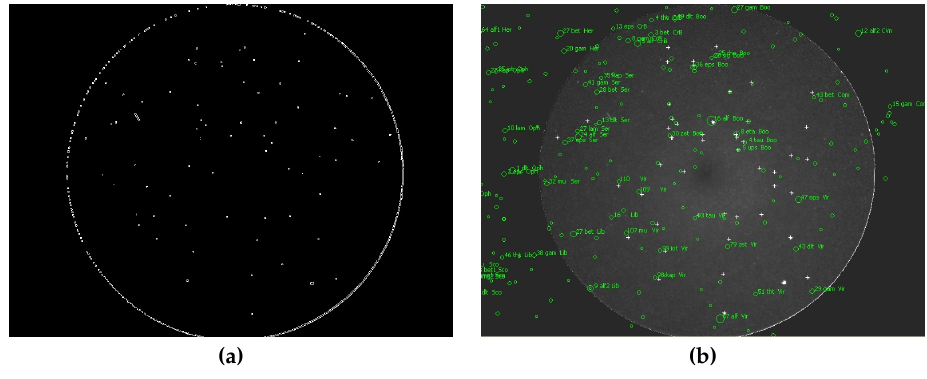
Figure 7. Calibration of the frame. ( a ) Edges detected by Canny filter; ( b ) Identified